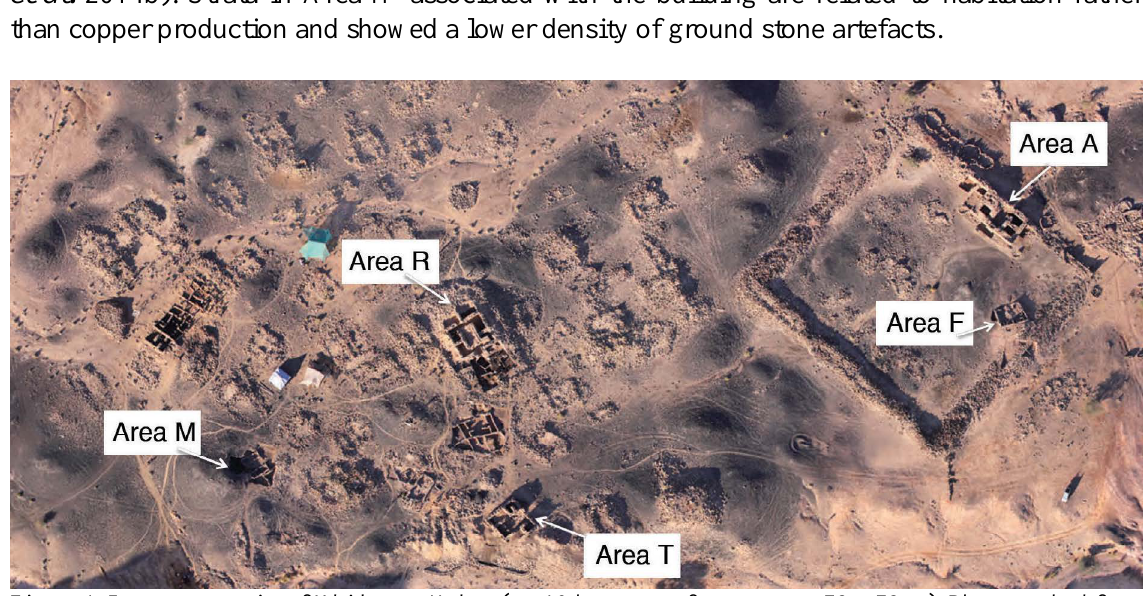
Figure 4. Image composite of Khirbat en-Nahas (ca. 10 ha; square fortress = ca. 73 x 73 m). Photographed from altitude of approximately 200 m. Areas A, F, M, R, and T were excavated in 2006. For scale, note the pick-up truck at lower right. Modified from Levy et al. 2014a.